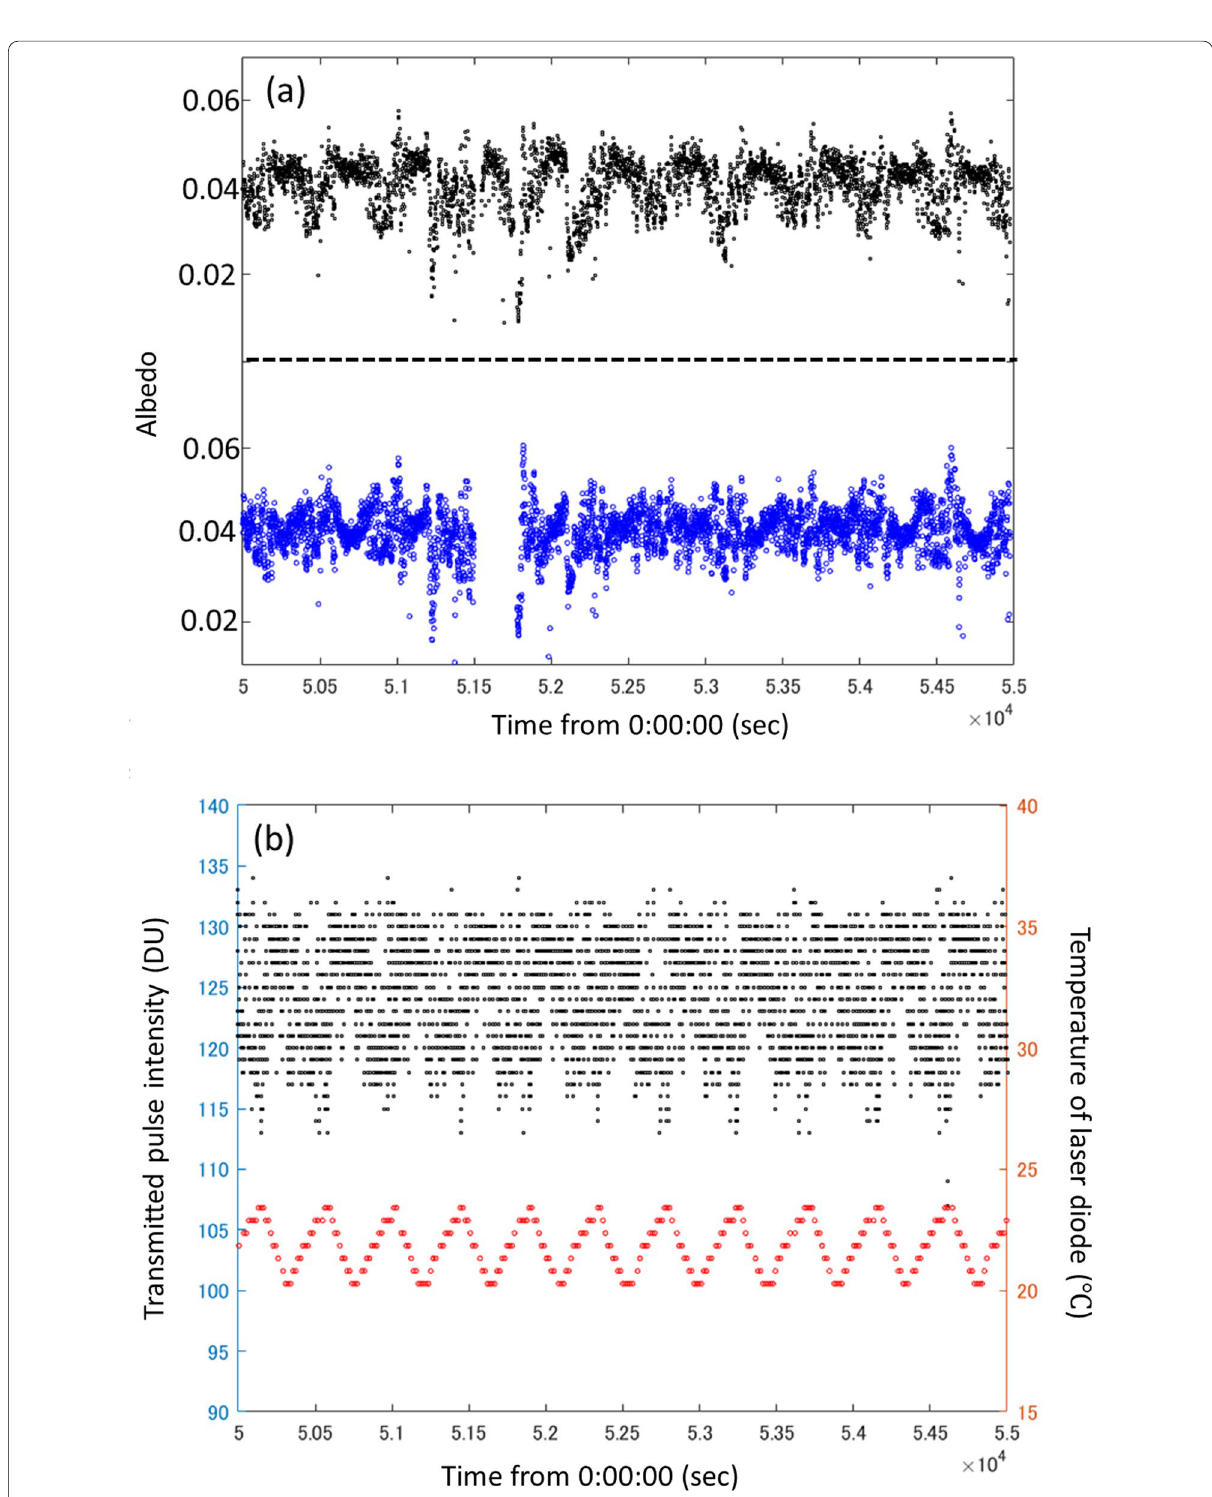
Fig. 11 a Time variation of the albedo derived from the LIDAR data: uncorrected albedo in the top panel and corrected albedo in the bottom panel. b Time variation of the transmitted pulse intensity (black points) and the temperature of the laser diode of the transmitter (red points). The data were taken on 20 July